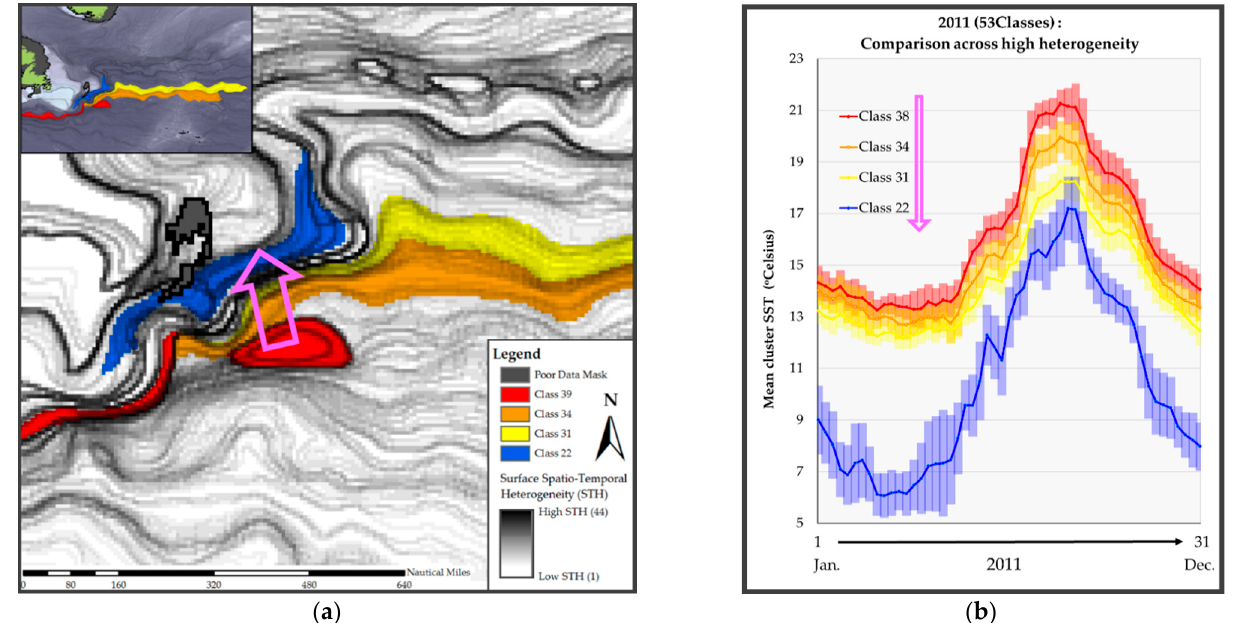
Figure 9. Heterogeneous areas separating water masses with different temporal characteristics in waters surrounding the Flemish Cap. ( a ) An example of how areas displaying high STH values separate areas of the ocean surface that display different temporal signals, across the high STH value area (pink arrow). The top left hand side insert shows the extent of these four classes across the North Atlantic. ( b ) The matching temporal profiles of the four clusters, depicted here using mean temperature, and standard deviation as a measure of variability across cluster pixels (error bars). Note that cluster colour is not an indication of temperature, with a pink arrow indicating the sequence of classes in both panels.